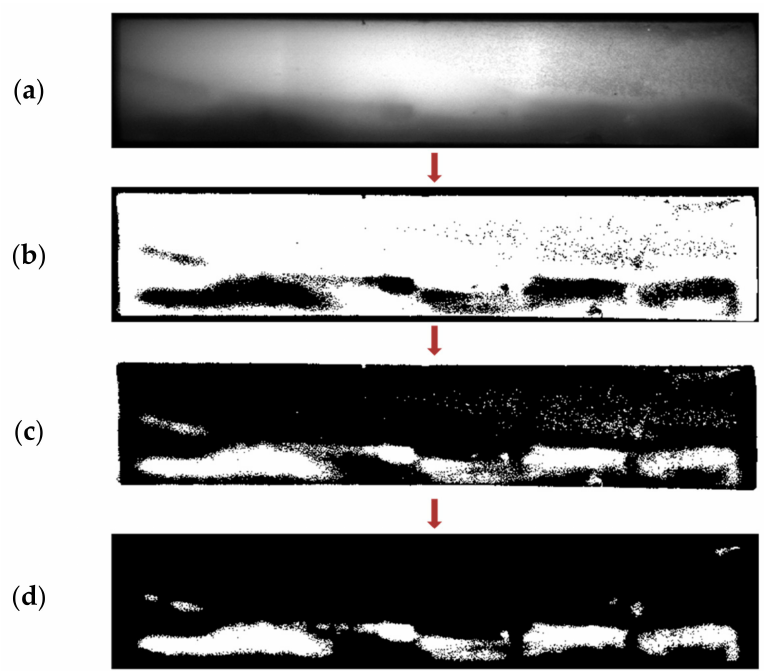
Figure 12. The step-by-step binary maps obtained for the detection of flow skewing with a faulty sample cartridge. ( a ) The captured image of the faulty cartridge. ( b ) Obtained binary map. ( c ) Inverted binary map making the skewed flow foreground. ( d ) Final processed flow segmented map obtained, the area of which is calculated to verify for